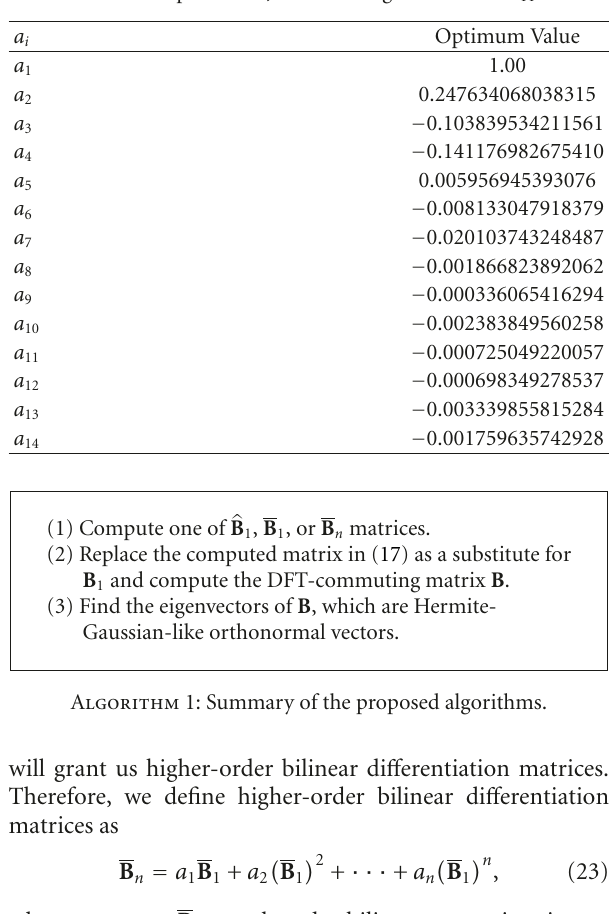
Table 1: Optimum a i coe ffi cients generated for B 14 .